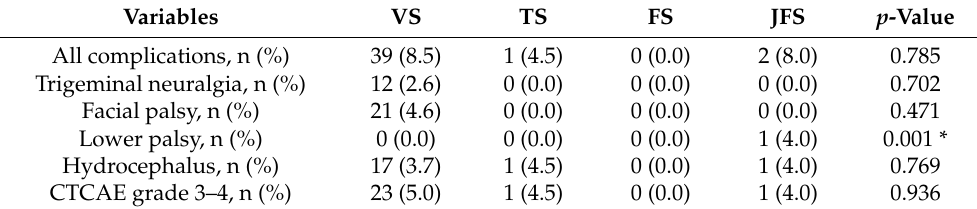
Table 3. Summary of radiation-induced adverse events after SRS before matching. Variables